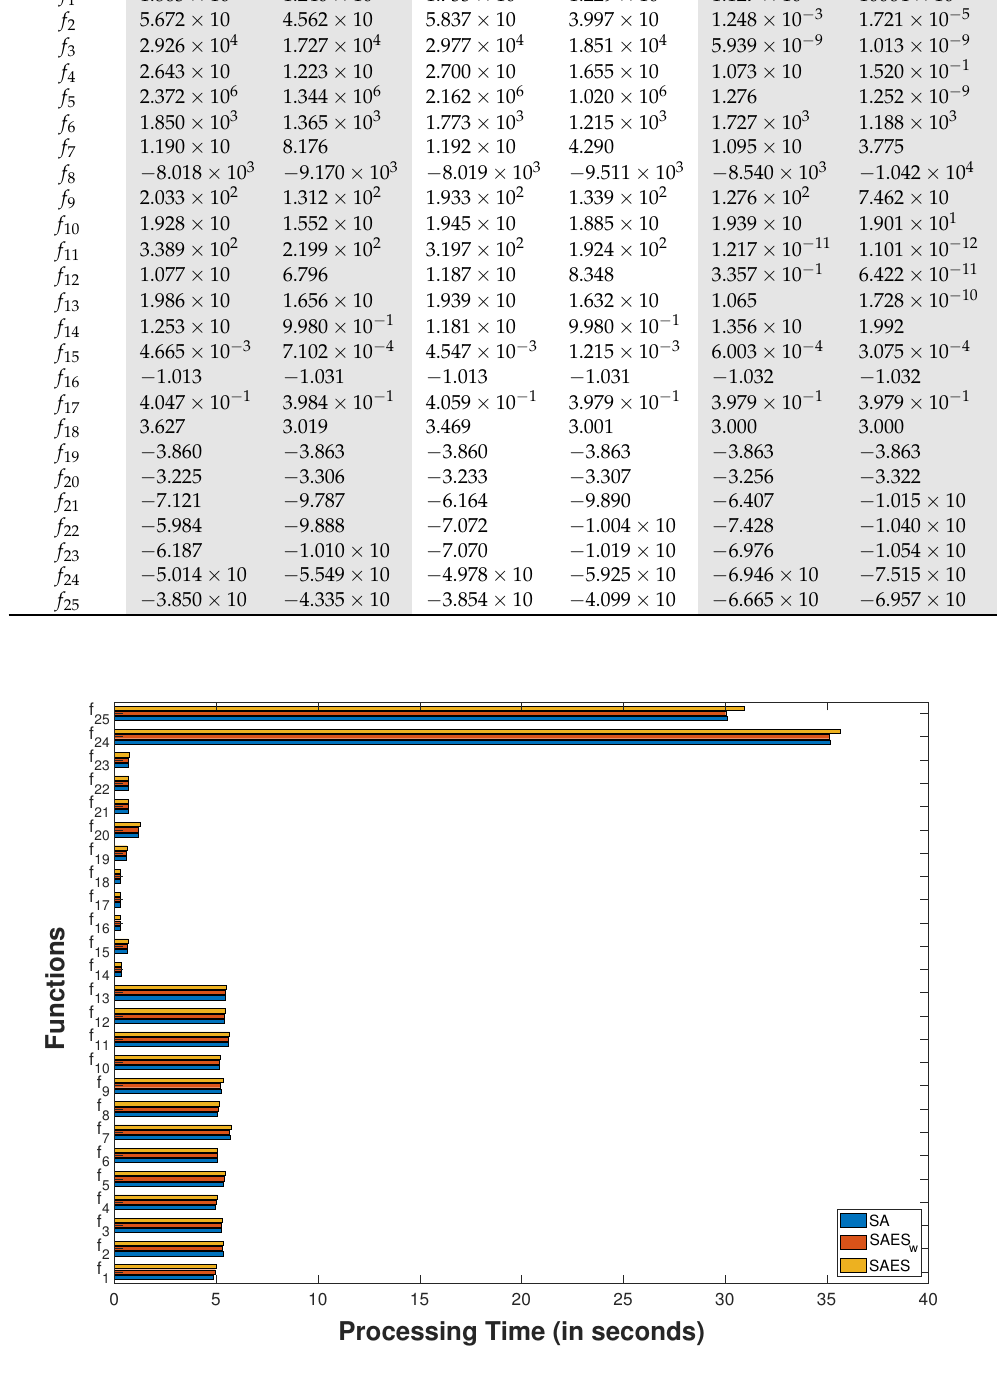
Figure 3. Averages of processing time in seconds using the classical test